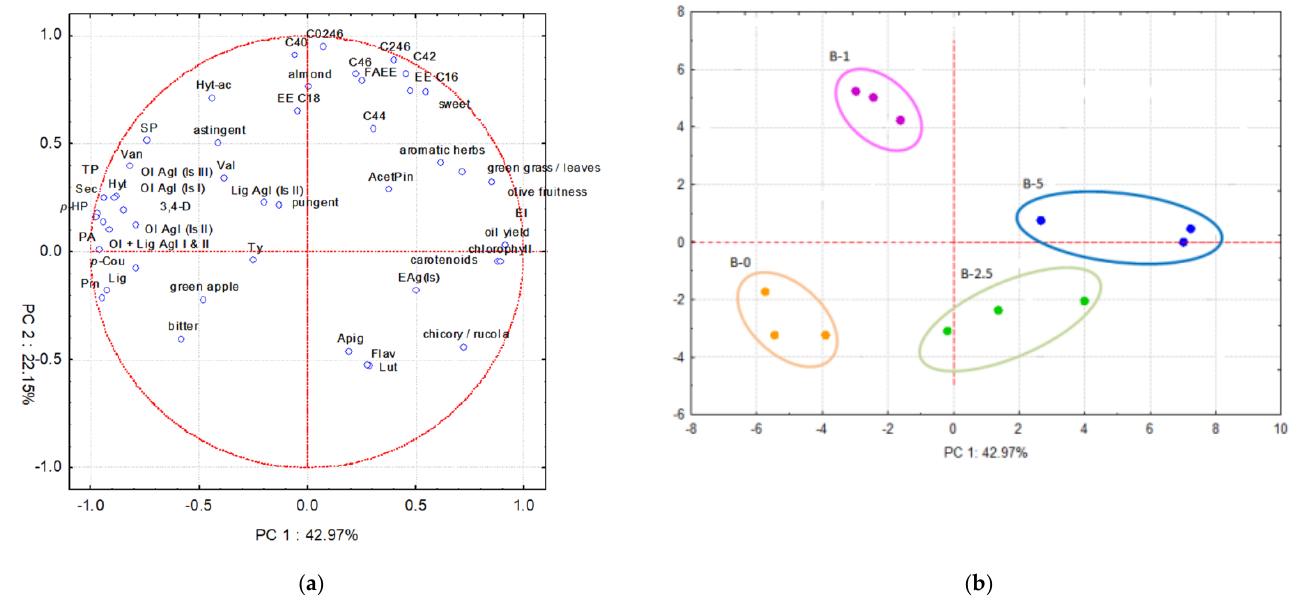
Figure 6. ( a ) Factor loadings of selected variables (quantity parameters, pigments, waxes and FAEE, the intensities of odor sensory attributes and concentrations of phenolic compounds) along the directions of principal components PC1 and PC2. ( b ) Separation of Buža olive cultivar oils according to the rate of leaf addition on PC1 and PC2 (full orange circles—oils produced without leaf addition (B-0), full violet circles—oils produced with 1% of leaf addition (B-1), full blue circles—oils produced with 2.5% of leaf addition (B-2.5), full green circles—oils produced with 5% of leaf addition (B-5).